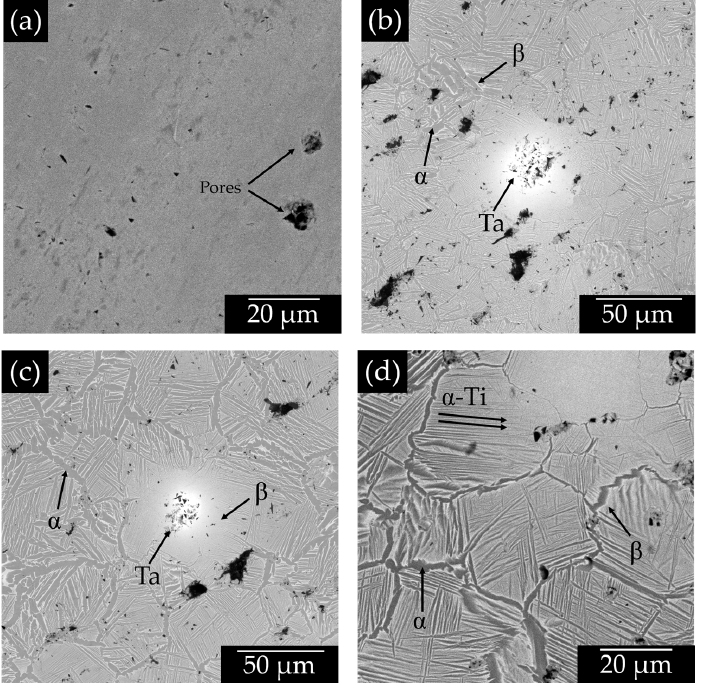
Figure 5. TSEM micrographs of the different Ti-xTa samples with ( a ) 0%; ( b ) 20 wt.%; ( c ) 25 wt.%; and ( d ) 30 wt.%.